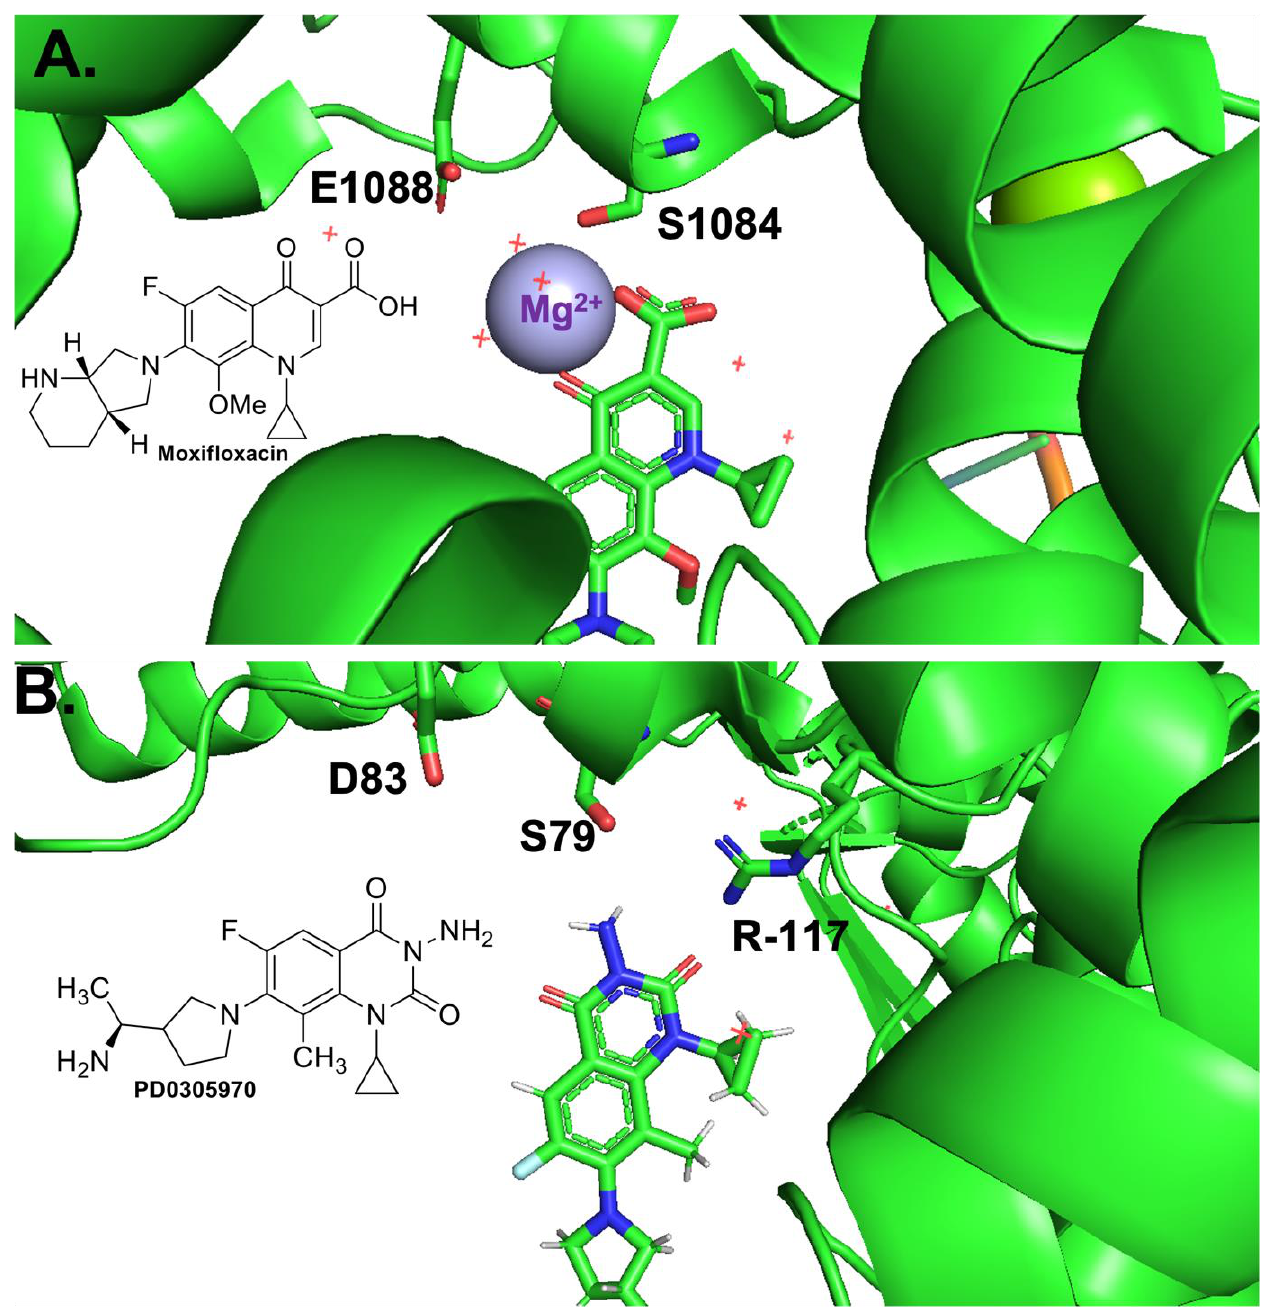
Figure 1. Crystal structures of a quinolone and a quinazolinedione interacting with topoisomerase IV-DNA cleavage complexes. ( A ) Crystal structure of moxifloxacin, DNA, and A. baumannii topoisomerase IV. Fluoroquinolone and key residues displayed as sticks, water molecules displayed as red +, divalent magnesium ion displayed in lavender. Adapted from RCSB PDB: 2XKK, visualized with The PyMOL Molecular Graphics System, Version 2.5.2 Schrödinger, LLC. Chemical structure of Moxifloxacin is shown in the inset. ( B ) Crystal structure of PD0305970, DNA, and S. pneumoniae topoisomerase IV. Quinazoline-2,4-dione displayed as sticks. Adapted from RCSB PDB: 3RAF, visualized with The PyMOL Molecular Graphics System, Version 2.5.2 Schrödinger, LLC. Chemical structure of PD0305970 is shown in the inset.